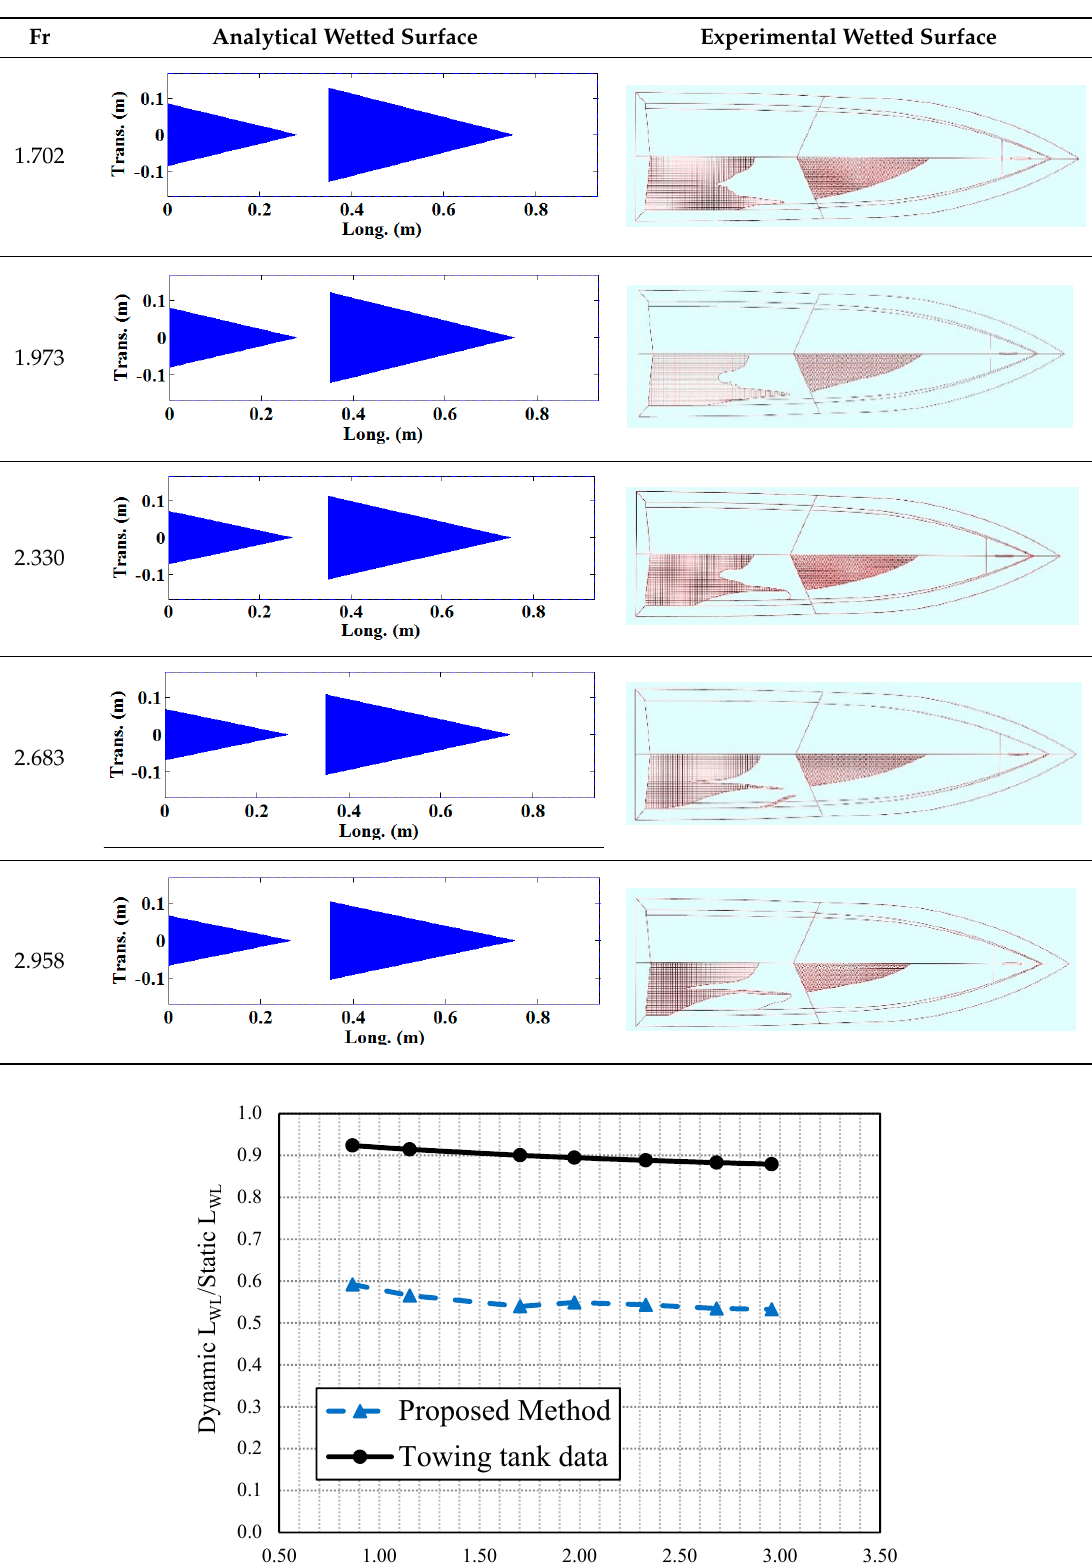
0.0 0.0 0.0 0.0 0.0 0.0 0.0 0.0 Figure 13. The dynamic wetted surface: 2D + T method vs. experimental Figure 13. The dynamic wetted surface: 2D + T method vs. experimental results. Figure 13. The dynamic wetted surface: 2D + T method vs. experimental results. Figure 13. The dynamic wetted surface: 2D + T method vs. experimental results. Figure 13. The dynamic wetted surface: 2D + T method vs. experimental results. Figure 13. The dynamic wetted surface: 2D + T method vs. experimental results. Figure 13. The dynamic wetted surface: 2D + T method vs. experimental results. Figure 13. The dynamic wetted surface: 2D + T method vs. experimental results. Figure 13. The dynamic wetted surface: 2D + T method vs. experimental results. Figure 13. The dynamic wetted surface: 2D + T method vs. experimental results. Figure 13. The dynamic wetted surface: 2D + T method vs. experimental results. Figure 13. The dynamic wetted surface: 2D + T method vs. experimental results.